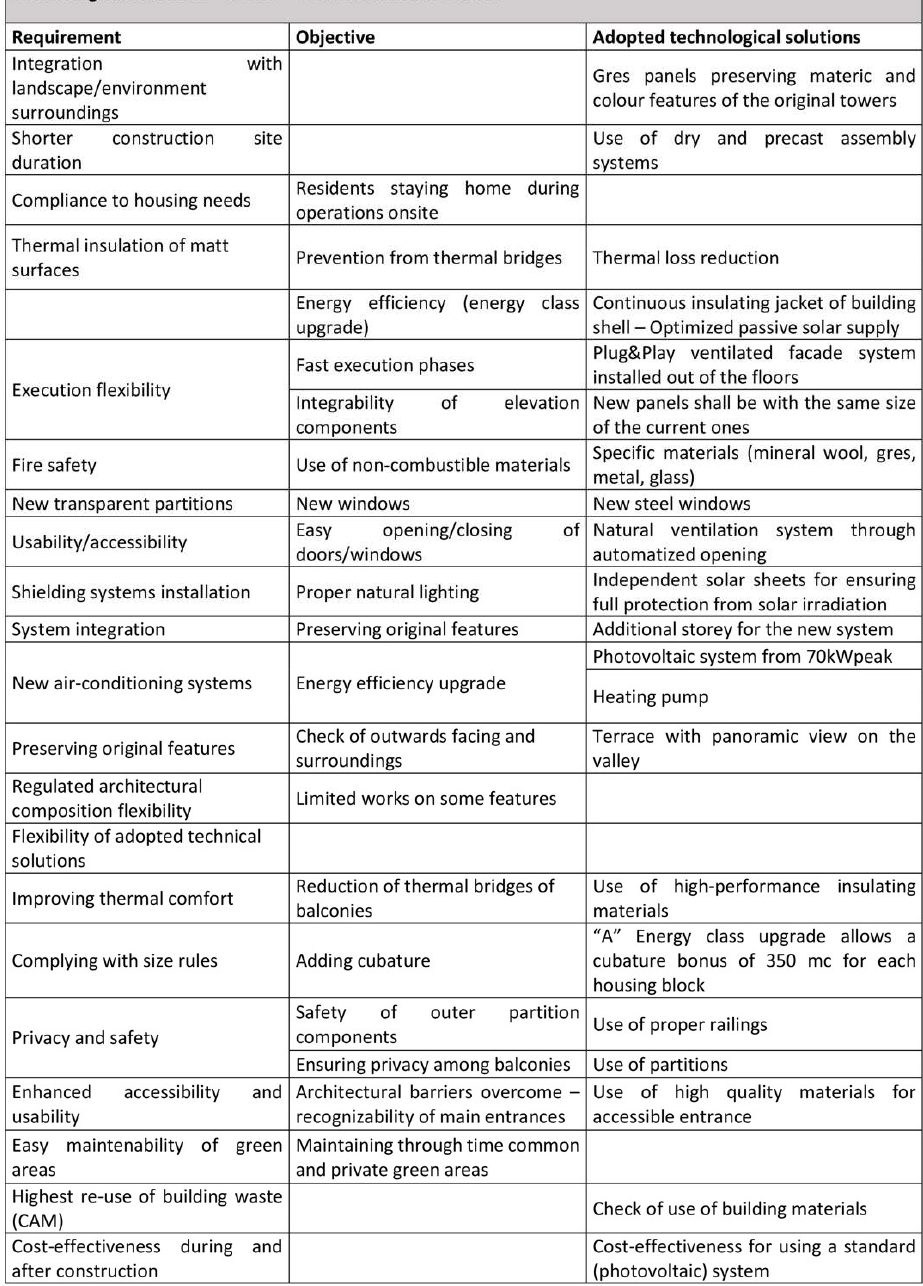
Figure 9. Indicators described in the preliminary design document for the Trento case study.